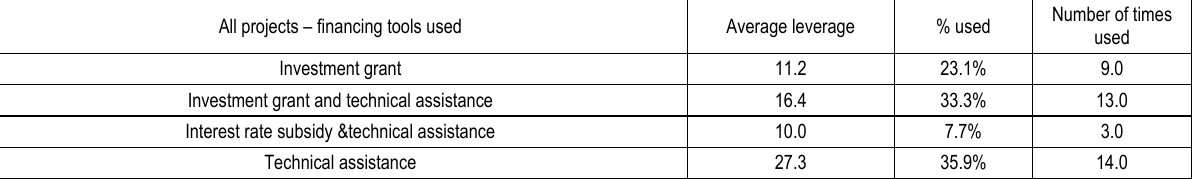
Table 2. Leverage rate of financing tools used within the EU-supported project sample